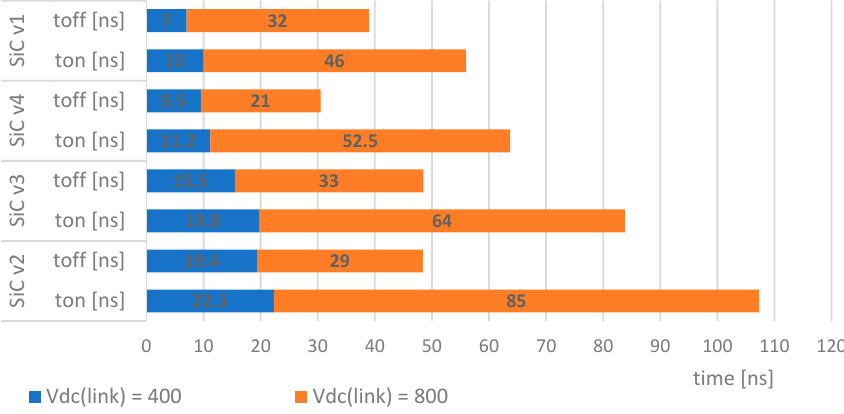
Figure 16. Evaluation of turn—on and turn—off times in dependency on DC link voltage.